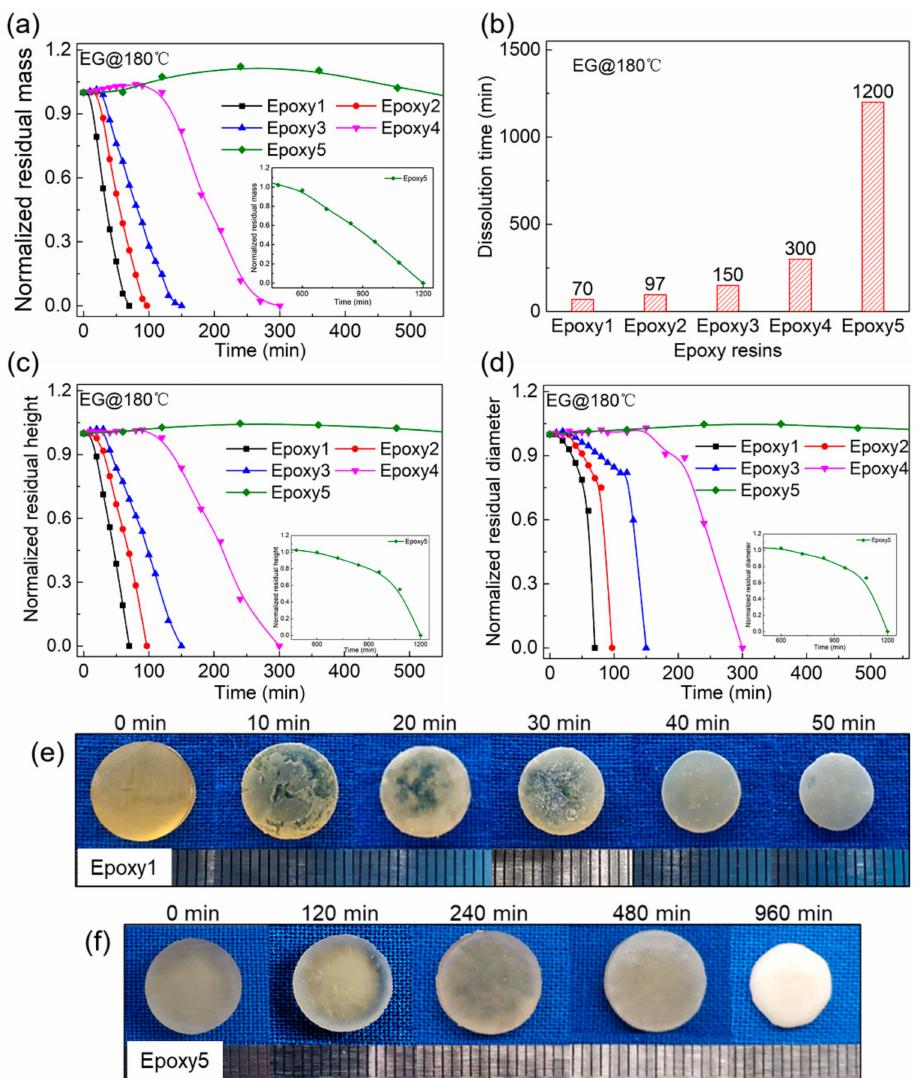
Figure 9. The dissolution of epoxy resins in EG at 180 ◦ C: ( a ) Normalized residual mass of samples with different contents of GA as a function of time. The inset figure shows the normalized residual mass evolution of Epoxy5 after being immersed in EG for 480 min; ( b ) The time required for the complete dissolution of samples; ( c ) Normalized residual height of epoxy resins as a function of time; ( d ) Normalized residual diameter of epoxy resins as a function of time; ( e ) The appearance and size evolution of Epoxy1; ( f ) The appearance and size evolution of